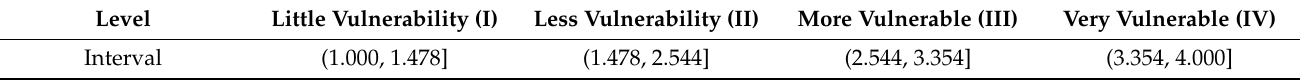
Table 3. Simulation grades based on SOA-RF